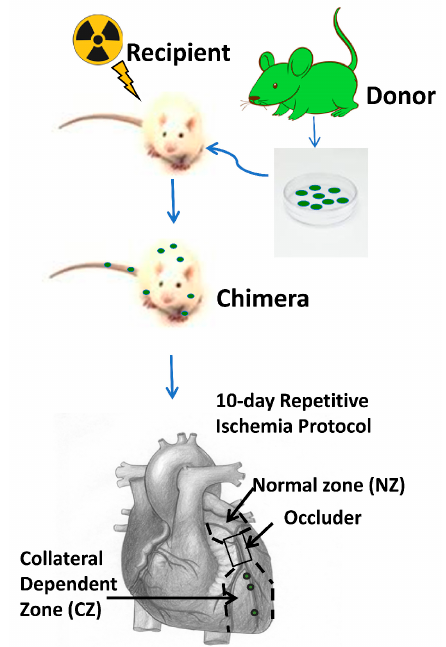
Figure 1. Schematic of bone marrow transplantation and rat coronary collateral growth (CCG) model induced by repetitive ischemia (RI). RI protocol was to occlude LAD for 40 s every 20 min for 3 h, then rest 5 h. Repeat for 10 days. Figure designed using assets from